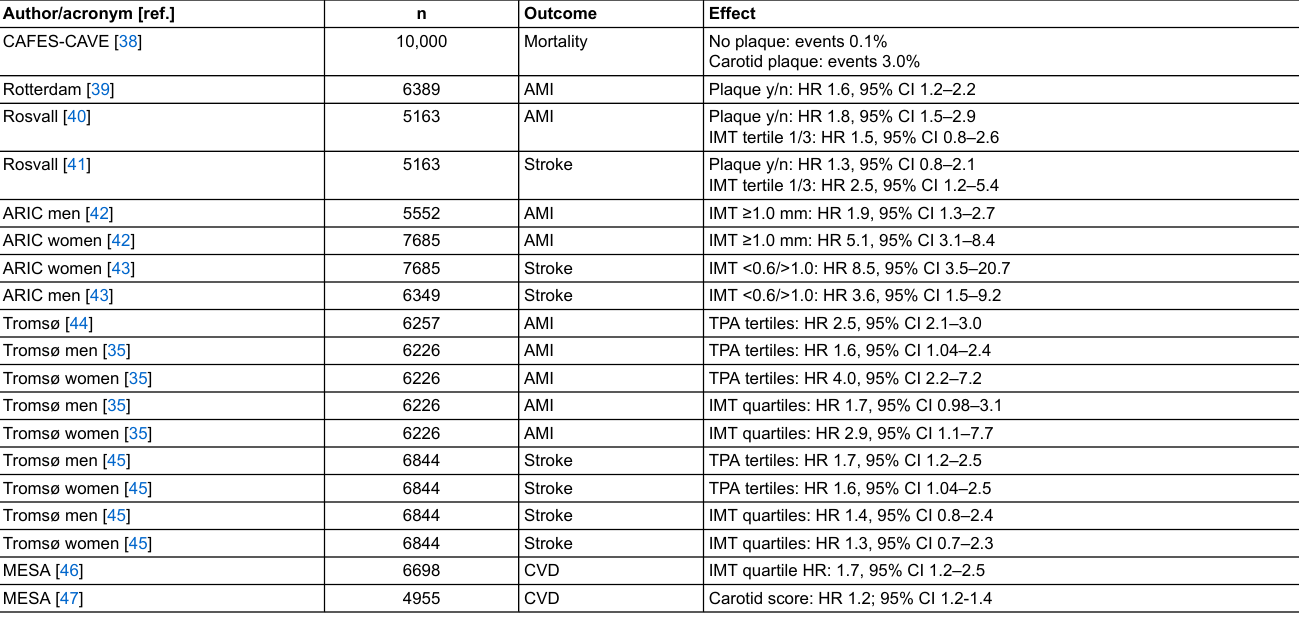
Table 2: a: Major outcome studies using carotid intima media thickness and carotid plaque. Author/acronym